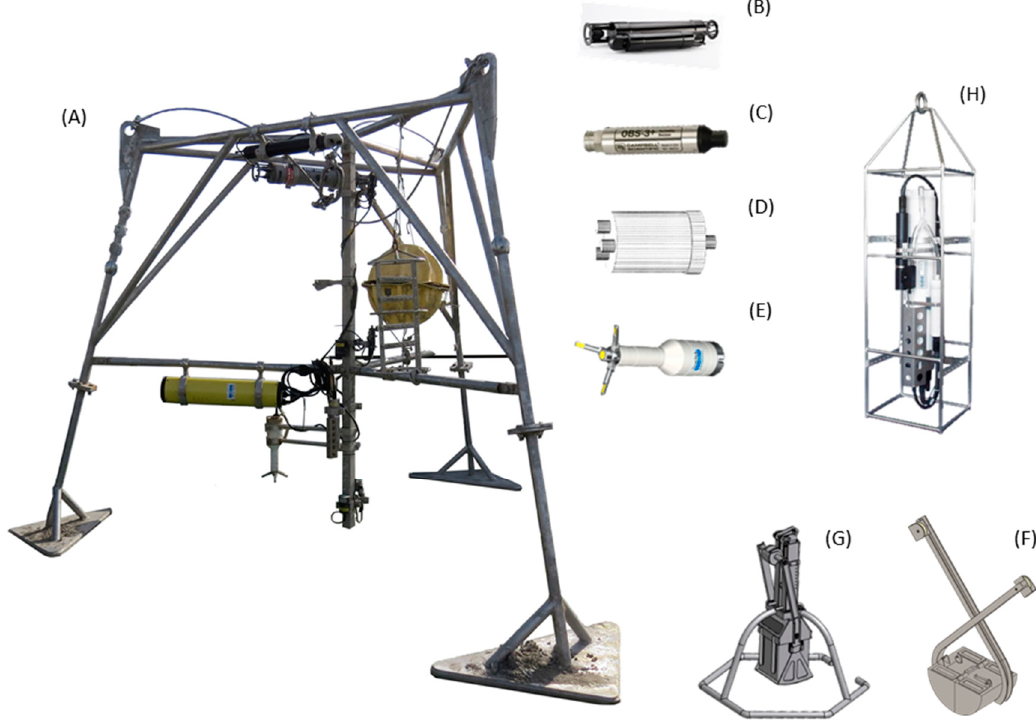
Figure 3. ( A ) Benthic lander equipped with a set of oceanographic sensors (see Table 1 for details about the instrumentation) deployed during the second experiment in the Westdiep study site. A similar lander was deployed for the third experiment. A chain of OBS+ sensors at 0.3, 1 and 2.4 m above bottom (mab) was present during the third experiment. In this image: ( A ) Benthic lander frame, ( B ) laser in situ transmissometer, ( C ) optical backscatter sensor, ( D ) acoustic backscatter sensor, ( E ) acoustic doppler velocimeter; and on-board winch-operated instruments, ( F ) Van Veen grab, ( G ) Reineck boxcore, ( H ) CTD frame, equipped with a OBS+ and a Niskin bottle.